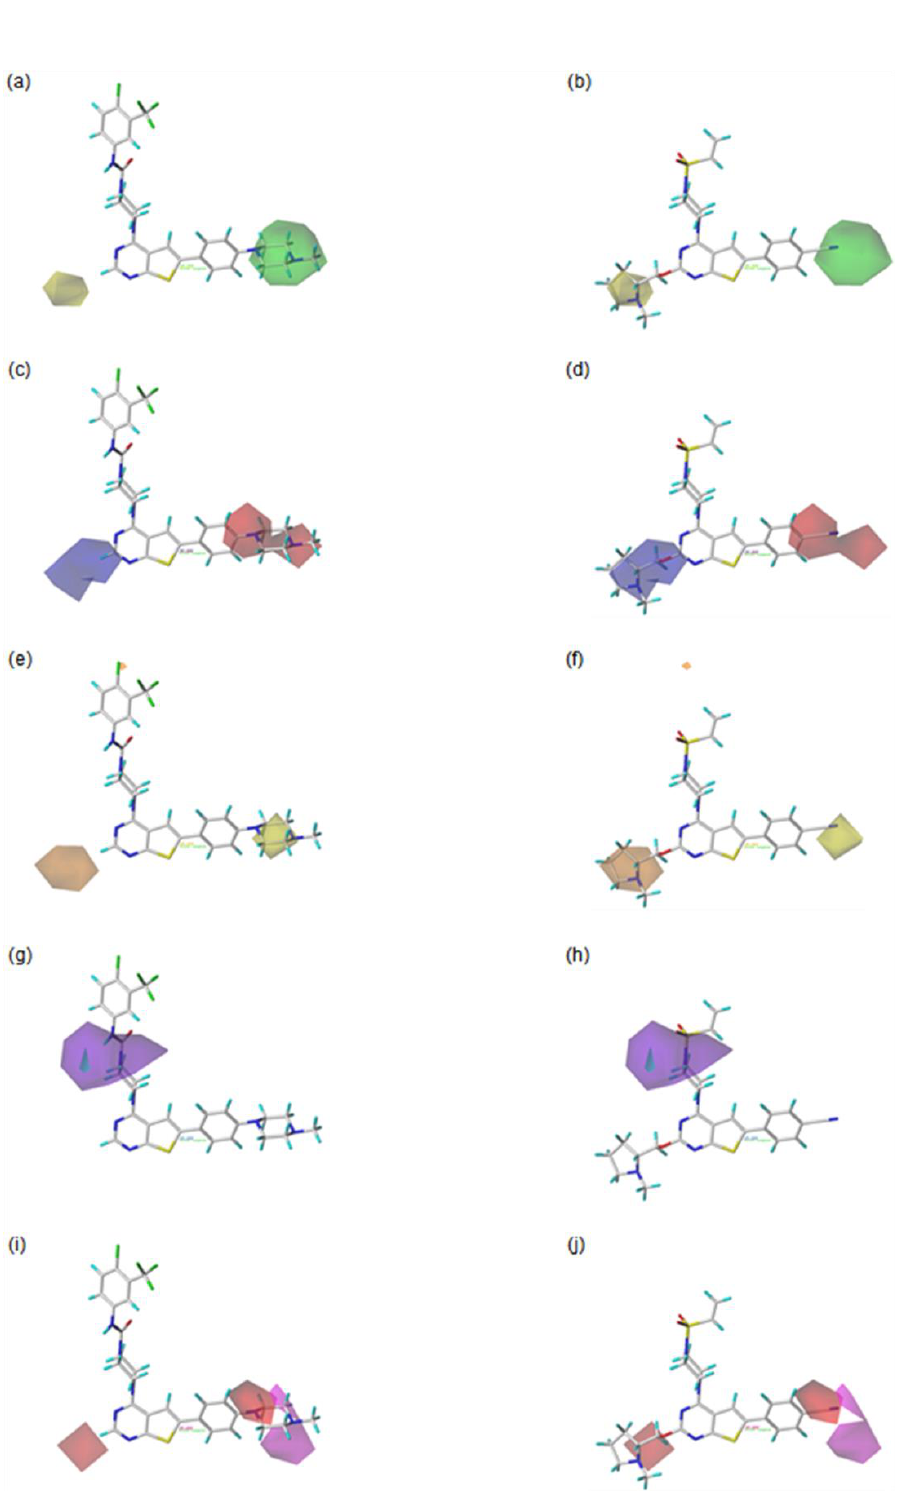
Figure 5. Contour maps of CoMSIA with the most active compound 42 ( left ) and the least active compound 20 ( right ). In each field, favored and disfavored areas are fixed with 80% and 20% contribution levels, respectively; ( a , b ) Steric field: favored regions are in green contours and disfavored regions are in yellow contours; ( c , d ) Electrostatic field: favored regions are in blue contours and disfavored regions are in red contours; ( e , f ) Hydrophobic field: favored regions are in orange contours and disfavored regions are in yellow contours; ( g , h ) Hydrogen bond donor field: favored regions are in cyan contours and disfavored regions are in purple contours; ( i , j ) Hydrogen bond acceptor field: favored regions are in magenta contours and disfavored regions are in red contours.